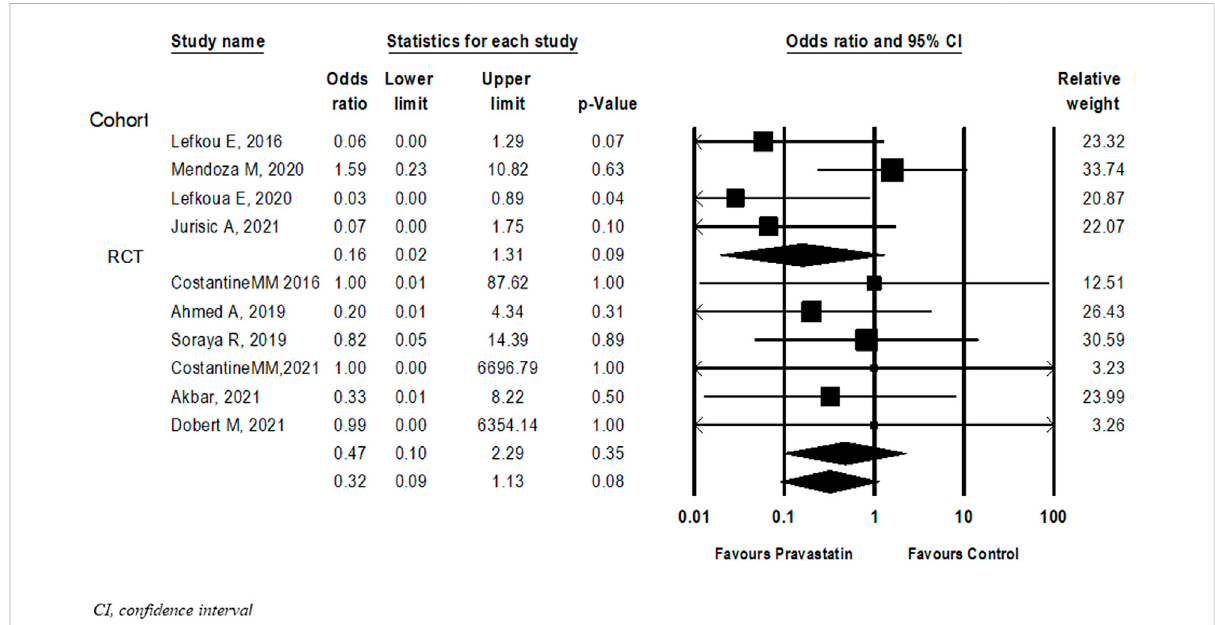
FIGURE 4 Meta-analysis results of Odds ratios for perinatal death following pravastatin treatment versus a control